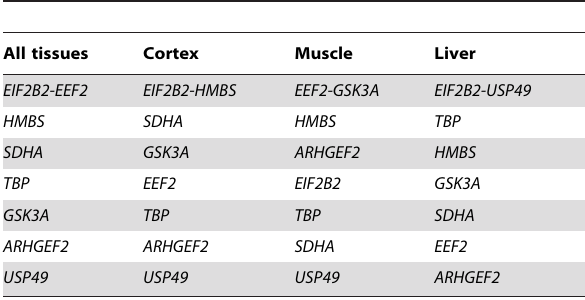
Table 3. Ranking of candidate control genes after geNorm analyses for individual and combined